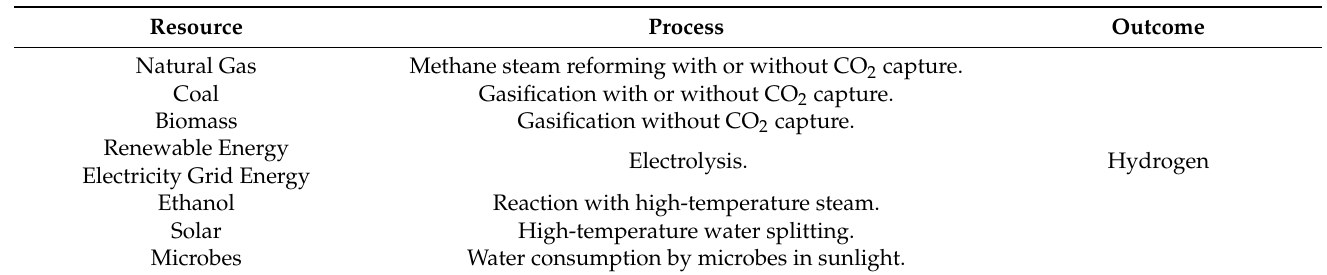
Table 15. Means of hydrogen